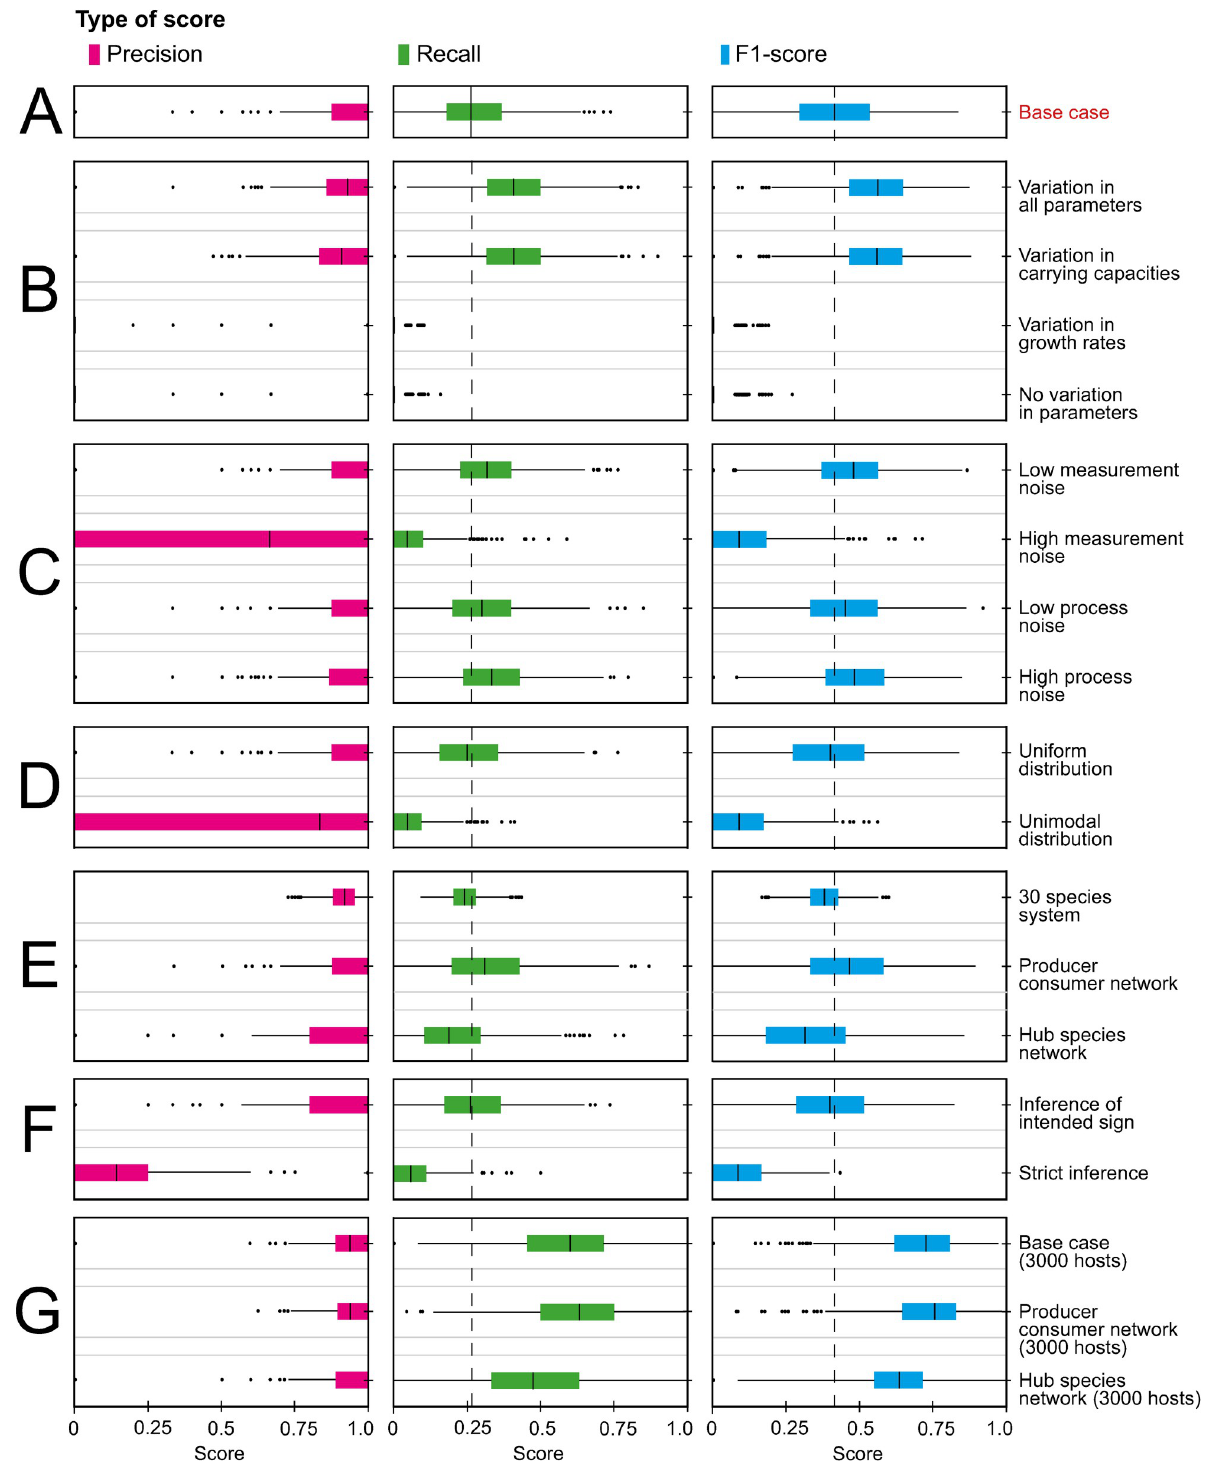
Fig 4. Inference under various sources of process variability. For the different scenario’s we show the precision, recall and the F1-score. (A) The base case model. (B) Host-specific variation in the carrying capacities and intrinsic growth rates. (C) Decreased and increased amount of measurement noise ( υ ) and the effect of process noise ( W ) (S2 Fig). (D) Interaction strengths drawn from a uniform and unimodal distribution (S3 Fig). (E) The results for a 30 species system, a network based on a producer-consumer structure and a network with hub interactions (S4 Fig). (F) The effect of network inference when specifying the intended sign in correlation analysis, as the sign of the strongest interaction in each pair of species, or